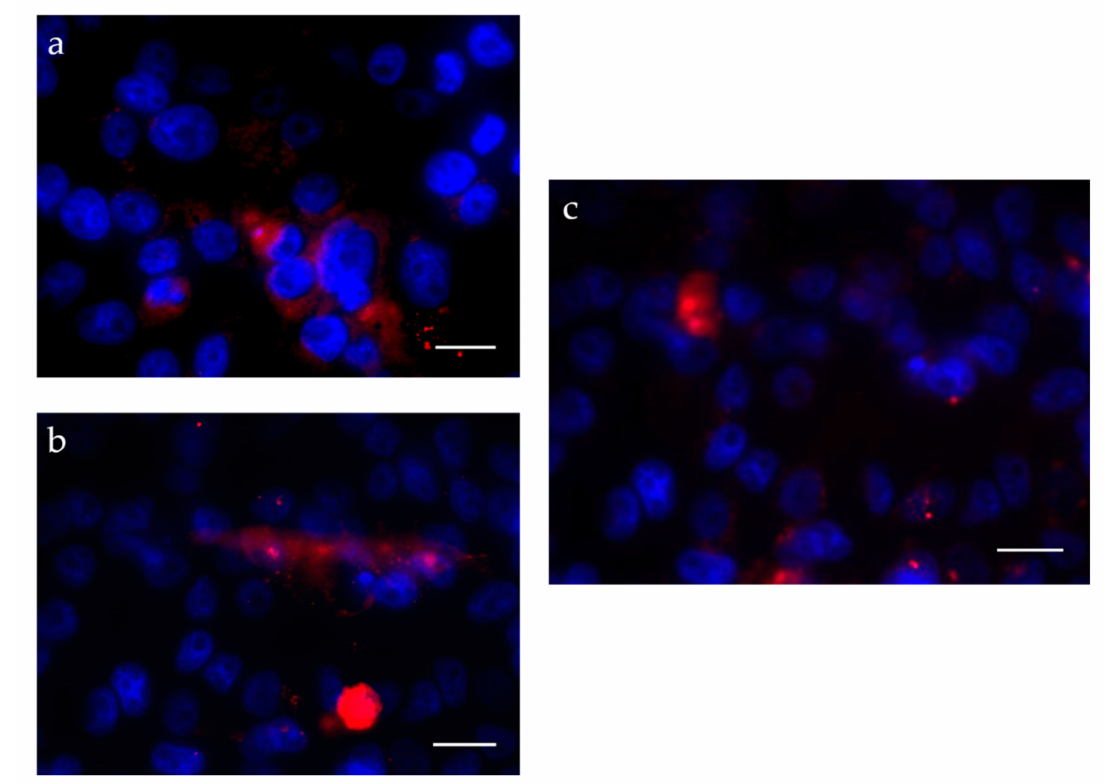
Figure 8. Fluorescent micrographs of SLN in HaCaT cells: ( a ) empty SLN, ( b ) etofenamate-loaded SLN, ( c ) ibuprofen-loaded SLN. (Scale bar 50 µ